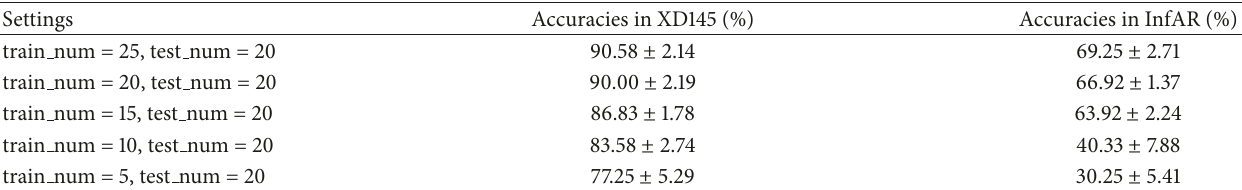
Table 1: The average recognition precision (%) of iDTs feature in XD145 and InfAR datasets. train num and test num denote the number of samples in training and testing sets,